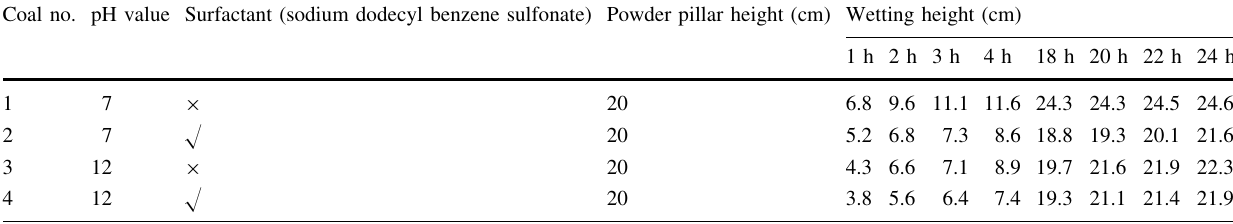
Table 4 Experimental results of pulverized coal’s self-priming in different solutions (the first group) Coal no. pH value Surfactant (sodium dodecyl benzene sulfonate) Powder pillar height (cm) Wetting height (cm)